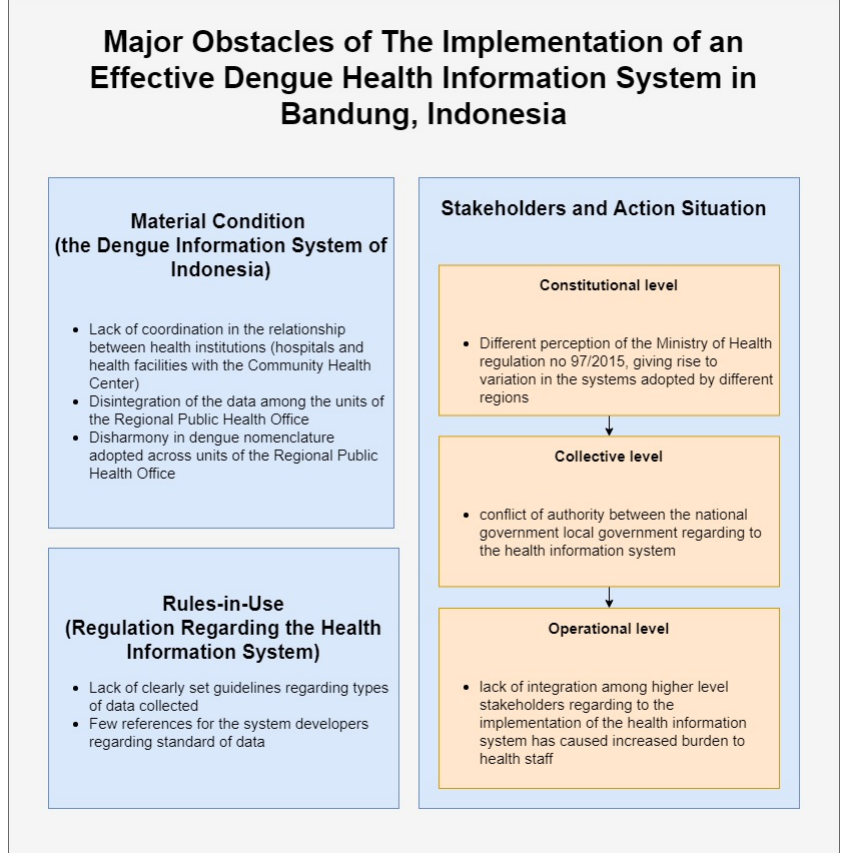
Figure 5. Summary of major obstacles identified that hinders an effective implementation of the health information system in dengue . information system in